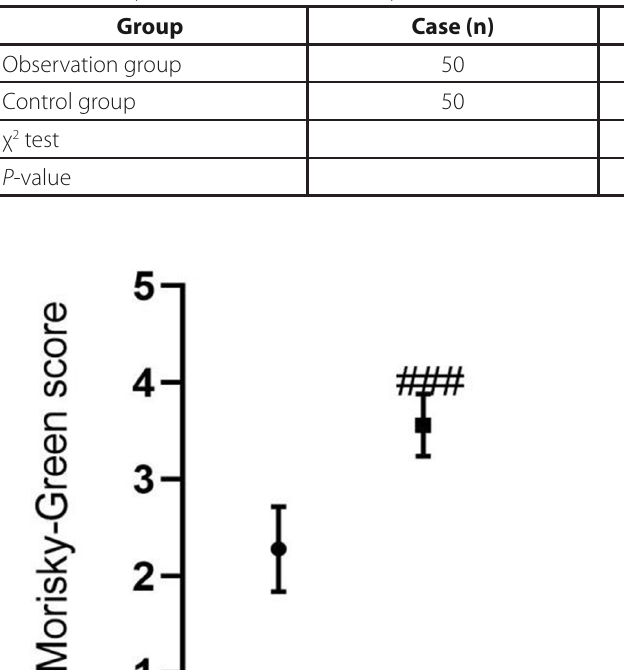
Table 2. Comparison of medication compliance between the two groups after continuing care.